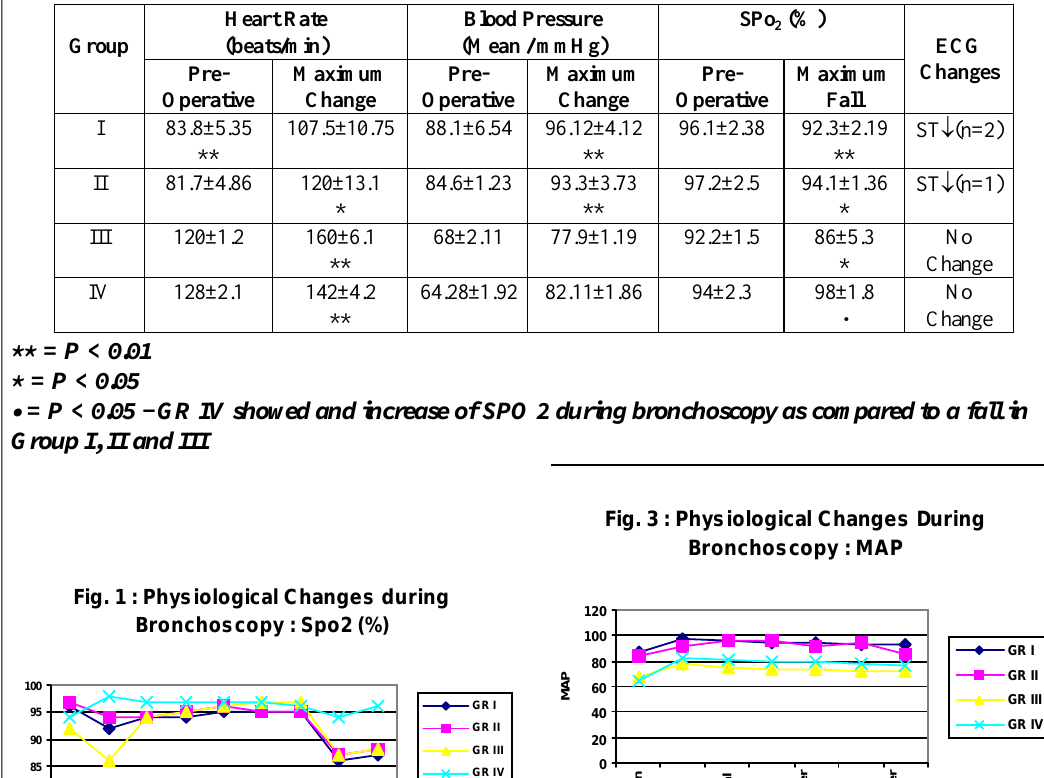
All the data were expressed as mean